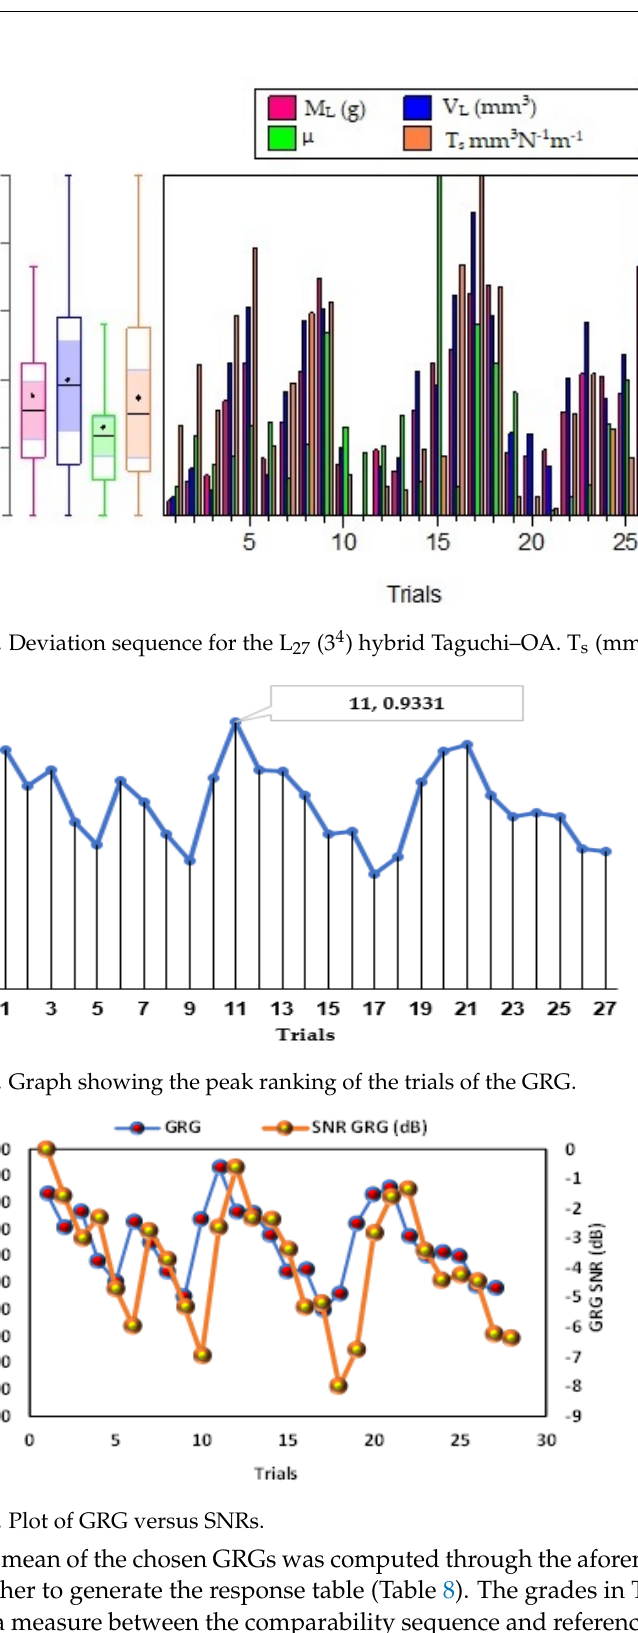
Figure 15. Reference sequence values for the L 27 (3 4 ) hybrid ‐ Taguchi OA.